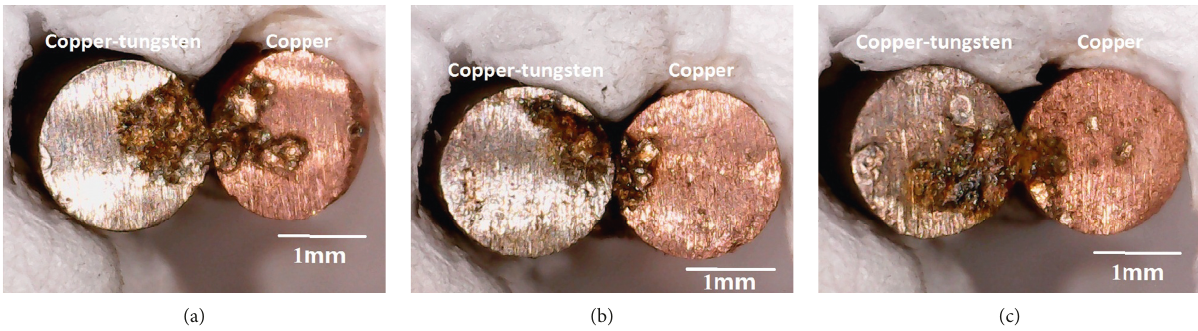
Figure 5: Discharge point distribution on the surface of copper-tungsten and copper